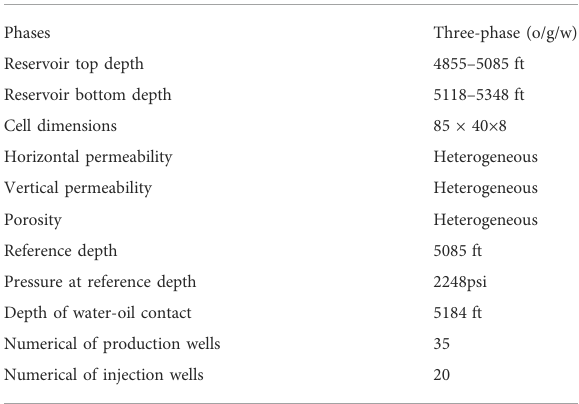
TABLE 5 Reservoir model parameters used in the fi eld example.